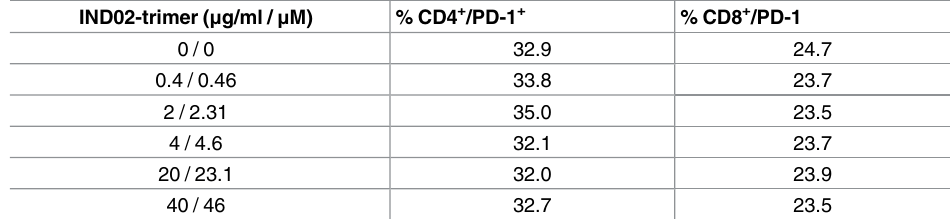
Table 3. IND02-trimer alone did not alter expression of Tim-3 and PD-1 on CD8 + T